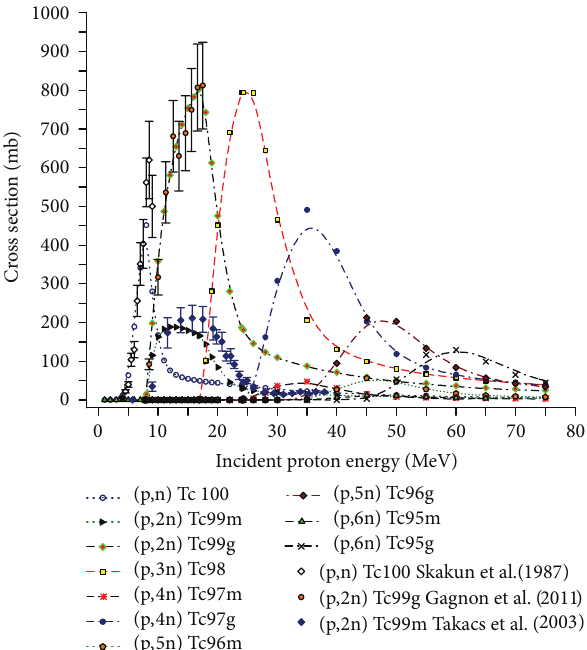
Figure 5: The collection of 100 Mo(p,pxn) 𝑥𝑥 Tc theoretical excitation functions from the TENDL 2012 library [24] up to the (p,6n) level. The experimental measurements for 99𝑔 Tc (Gagnon et al. [12]), 100𝑔 Tc (Skakun et al. [25]), and 99𝑚 Tc (Takacs et al. [5]) productions are included for